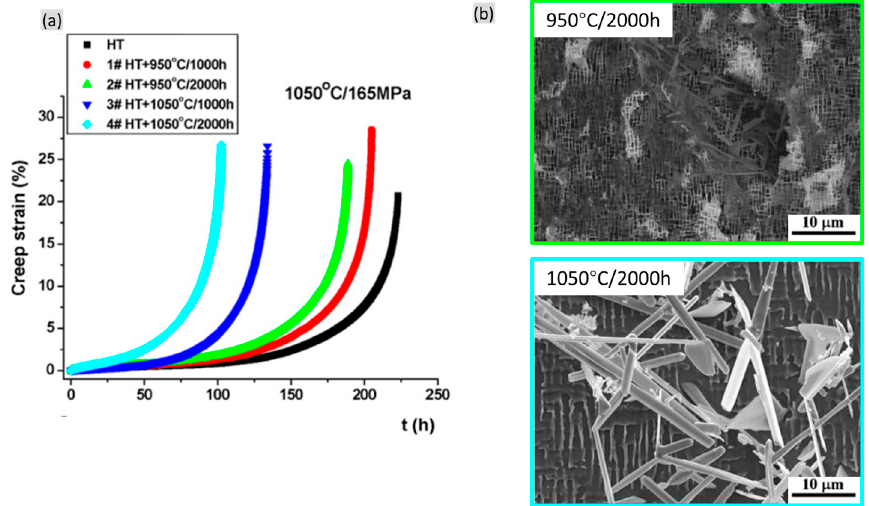
Figure 18. Effects of exposure time on the stress rupture life of DD6 alloy at 1070 °C/140 MPa after long-term exposure at ( a ) 980 °C and ( b ) 1070 °C. The associated microstructures after thermal ex- posure are also presented [34].